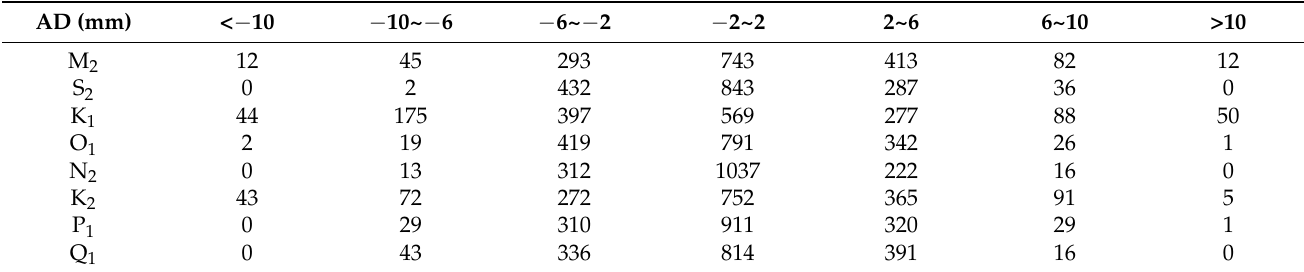
Table A1. Distribution of amplitude difference (AD) before and after the MVC of eight major tidal constituents in the South China Sea.